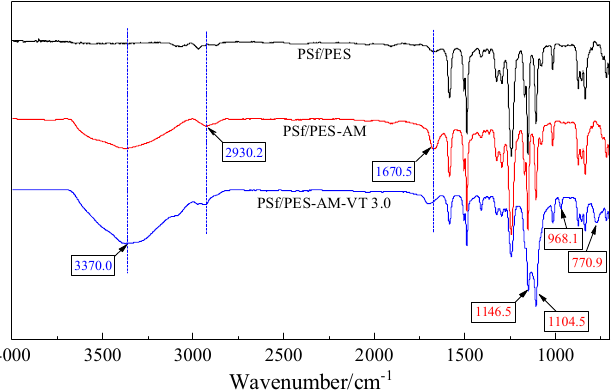
Figure 3. FTIR–ATR spectra of the neat and hybrid polymer membranes.